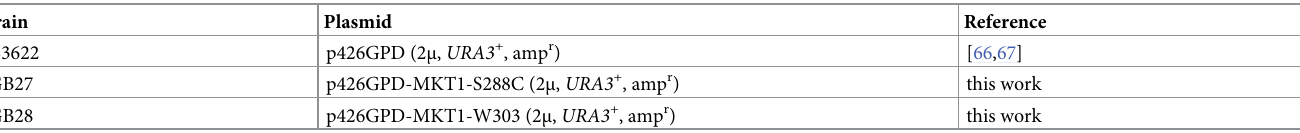
Table 2. Plasmids used in this